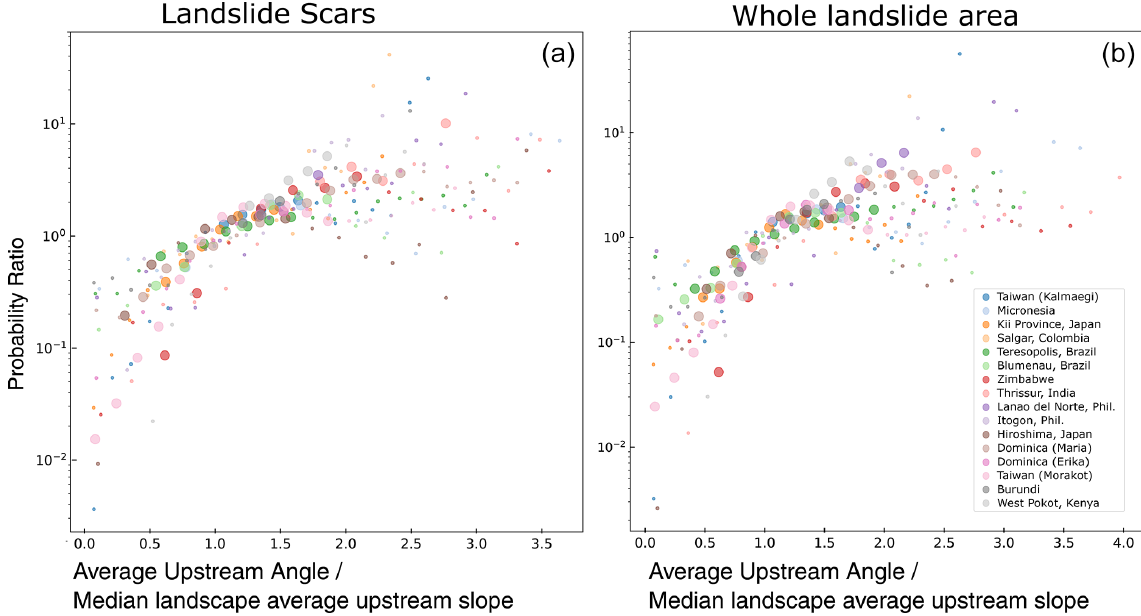
Figure 5. Landslide probability ratio against the average upstream angle normalized by the median of the local landscape, for the scar area (a) and the whole landslide area (b) . The size of the points depends on whether the difference between the landslide and topography exceeds the calculated confidence interval for that bin interval; larger points indicate significant deviation ( p > 0 . 95), and small points indicate the difference is not significant at that probability